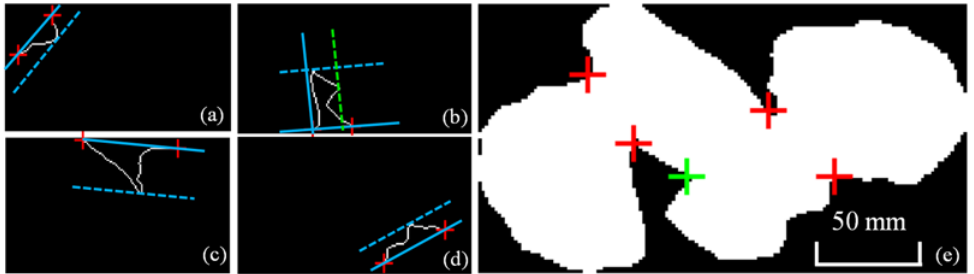
Figure 13. Pit detection results: ( a – d ) Visualization of Conjugate Detection pit Process, ( e ) Pit detection result. The bright green straight line in ( b ) and the bright green pit in ( e ) represent the additional detection effect of conjugate lines.